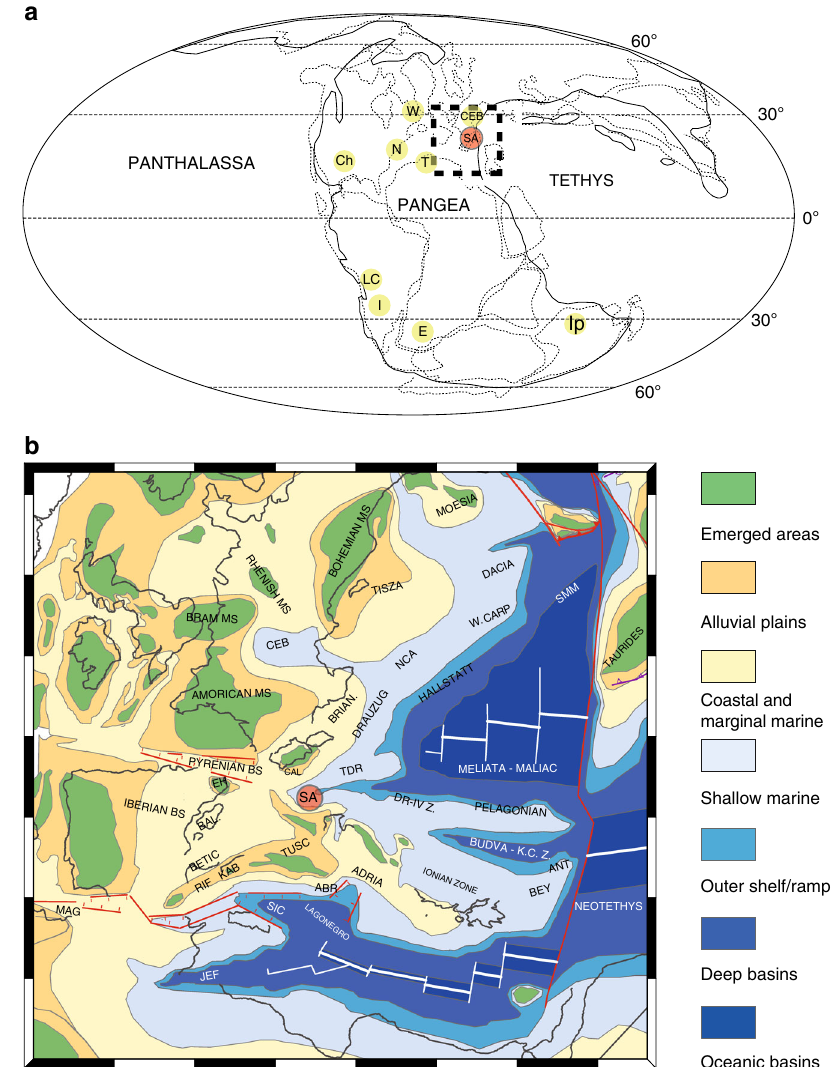
Fig. 2 Early-late Carnian (Late Triassic) palaeogeographic reconstruction. a World map, showing palaeogeography in the late Triassic, and the main vertebrate-bearing units mentioned in the text. Abbreviations: CEB: Central European Basin; Ch: Chinle/Dockum Group; E: Molteno and Lower Elliot Formation (South Africa); I: Ischigualasto Formation; Ip: Ipswich Coal Measures (Australia); LC: Los Colorados Formation (Argentina); N: Newark basin; SA: Southern Alps; T: Timezgadiouine Formation (Morocco); Wolfville Formation (Nova Scotia, Canada). b Palaeogeographic map of western Europe showing land and sea, and main tectonic blocks. Abbreviations (BS: Basin; MS: Massif): ABR: Lazio-Abruzzi platform; ANT: Antalya; BAL: Balearic Islands; BEY: Beydaglari autochtonous; BRAB: Brabham Massif; BRIAN: Brianconnaise; CAL: Calabria; CARP Carpatian; DR-IV: Drina-Ivanica Zone; EH: Ebro High;